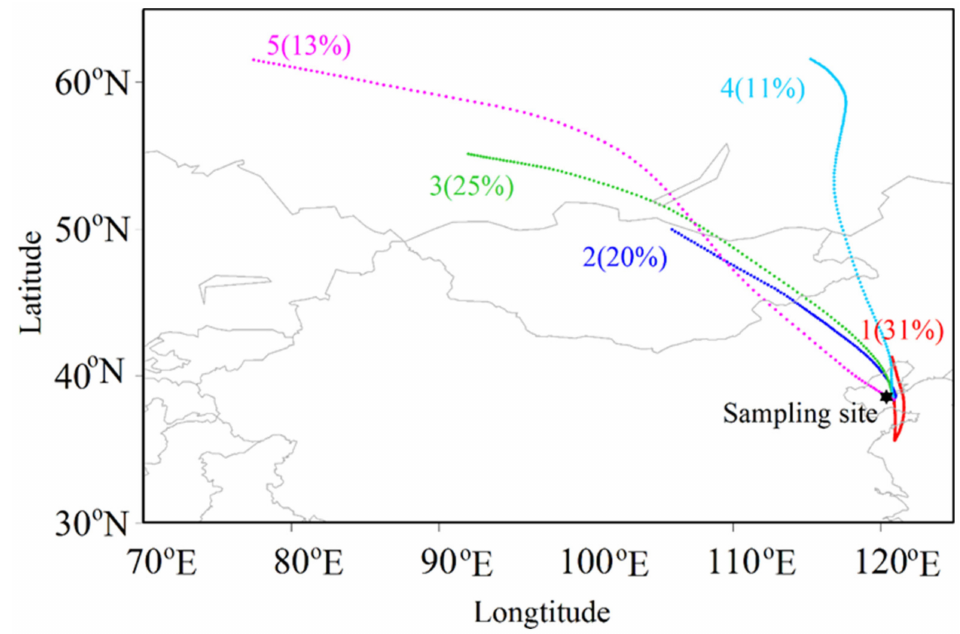
Figure 2. The 120 h back trajectory clusters during the sampling period.